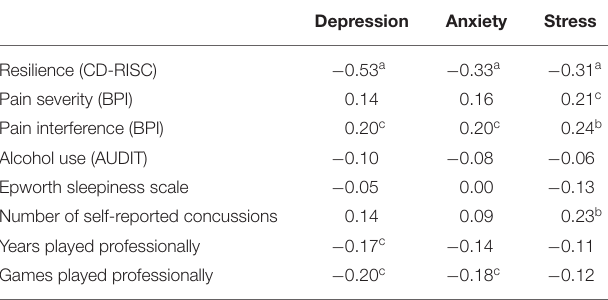
TABLE 5 | Bivariate Spearman